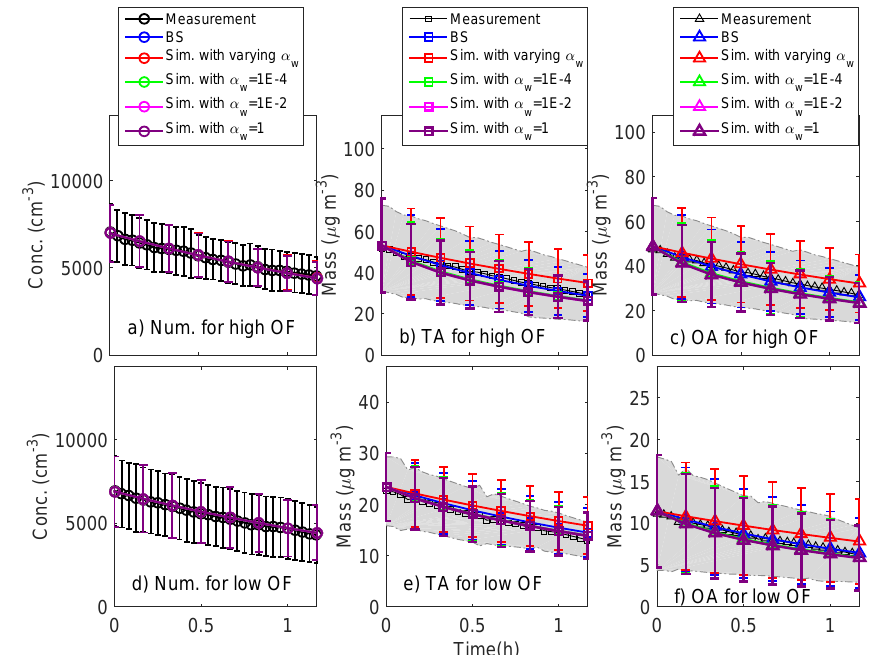
Figure 9. Similar to Fig. 2 except for the simulations with different accommodation coefficients of vapor with walls, α w , computed as a function of C ∗ (Zhang et al., 2015) and taking the values of 1 × 10 − 4 , 1 × 10 − 2 and i